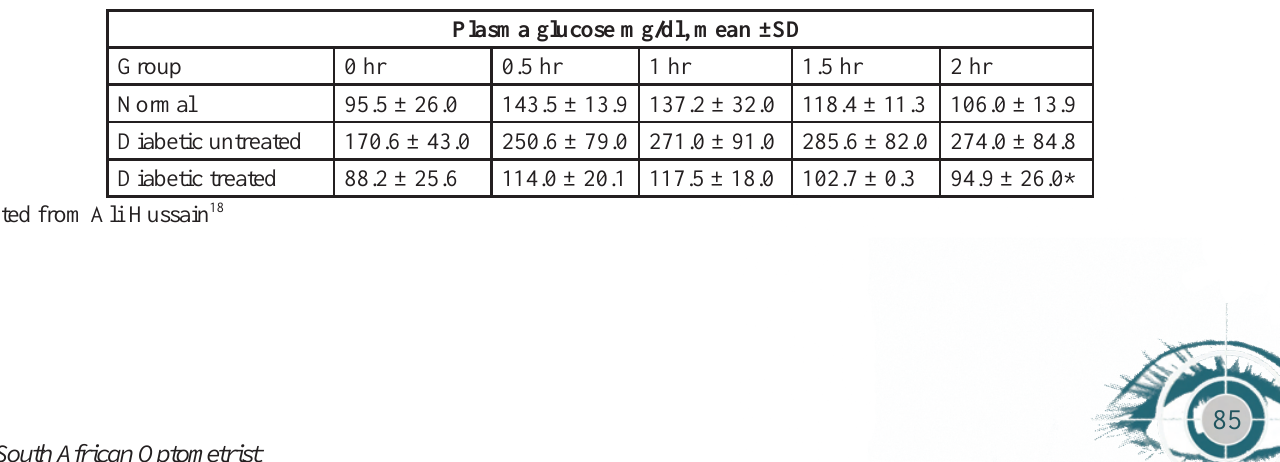
Table 3: Effect of treatment with water extract of Azadirachta indica leaves on glucose tolerance in diabetic rats after 16 weeks treatment. N=5, * p < 0.05 when compared with untreated diabetic group.